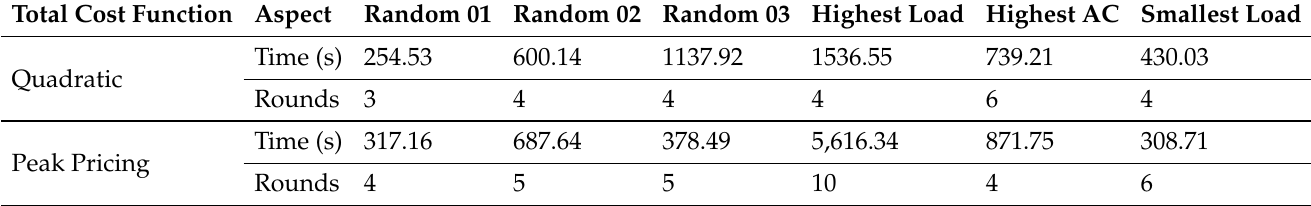
Table 5. BRD solution times when changing the complexity of each consumers’ problem (all instances have 10 consumers). Total Cost Function Aspect